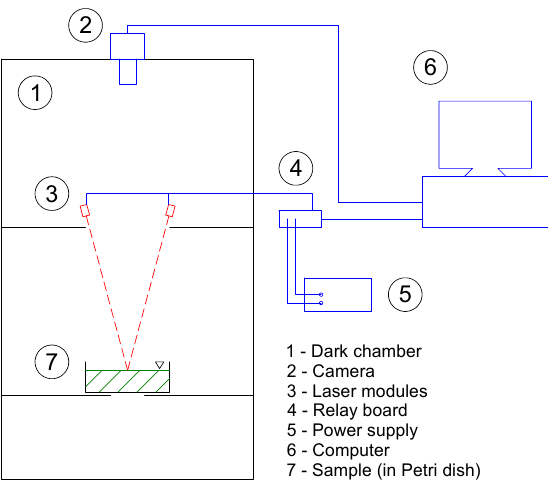
Figure 1. Vision system setup for laser-induced diffuse reflectance imaging.